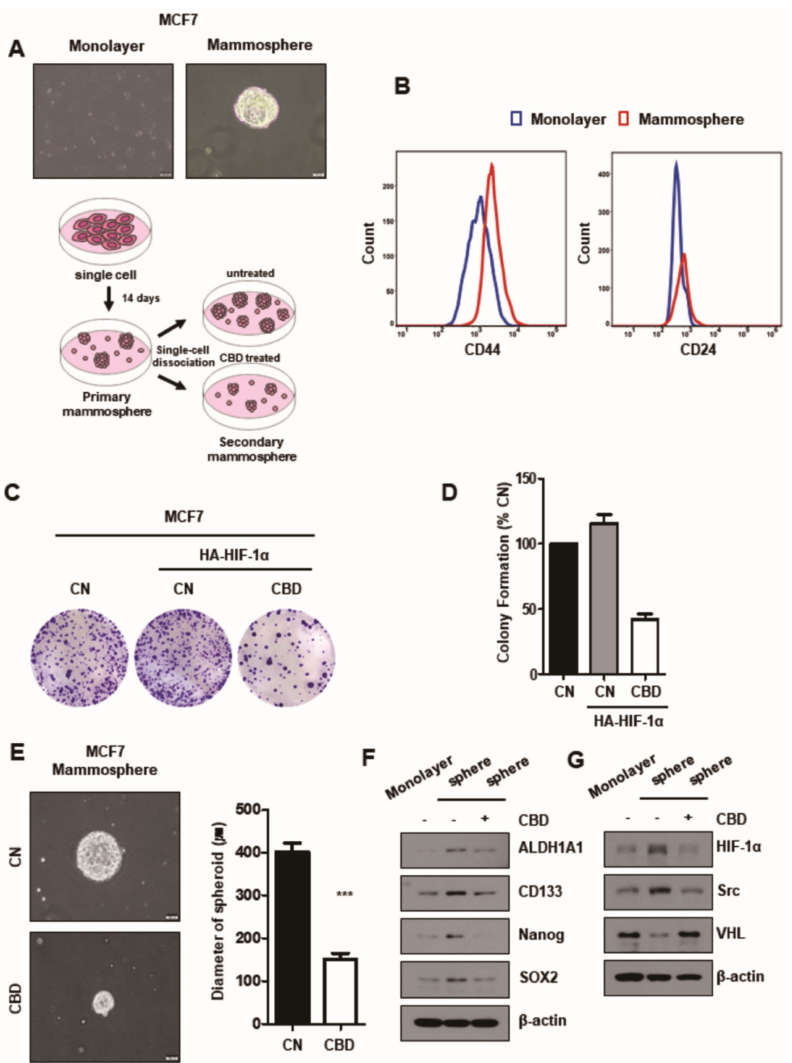
Figure 5. CBD reduces stemness of MCF7 breast cancer cells. ( A ) The sphere-forming cells were cultured in ultra-low coated-dishes for two weeks. Then, sphere-forming and monolayer cells were captured using a bright-field microscope. The scheme of the sphere-forming assay. ( B ) The monolayer cells and sphere-formed MCF7 cells were stained with breast cancer stem cell markers (CD44 or CD24) and analyzed by flow cytometry. ( C ) MCF7 cells were transfected with HA-HIF-1 α plasmid and treated with 2 µ M CBD. Cells were seeded on 6-well plates. After two weeks, the colonies were stained with crystal violet dye. ( D ) The number of colonies was counted. Colony numbers were identified in three experiments. ( E ) The sphere-forming cells were seeded in new ultra-low coated-dishes with or without CBD (2 µ M) for two weeks. Then, the secondary sphere-forming cells were captured using a bright-field microscope. The diameters of the spheroids in each dish were measured. ***, p < 0.001 ( F ) The stem cell-related proteins and ( G ) the protein levels of HIF-1 α , Src, and VHL were measured by Western blotting in both groups in secondary sphere-forming cells. β -actin was used as a loading control. CBD; cannabidiol, CN;